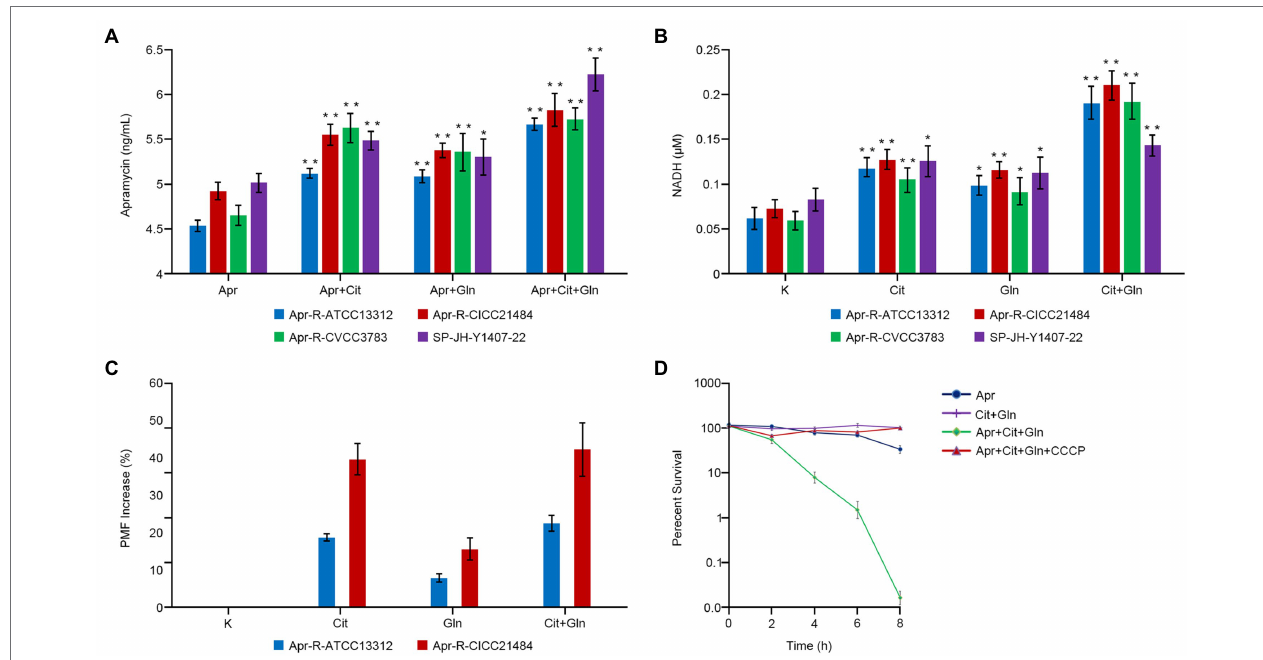
FIGURE 3 | Effect of exogenous citrulline and glutamine on intracellular drugs, NADH, and proton-motive force (PMF). (A) Concentration of Apramycin in bacteria cultured with different exogenous substances. (B) The NADH content of bacteria cultured with different exogenous substances. (C) The PMF of Apramycin-resistant Salmonella cultured with citrulline and (or) glutamine. (D) Survival curve of bacteria in different media with or without CCCP. “Apr” represents Apramycin alone, “Apr + Cit” represents the combination of Apramycin and citrulline; “Apr + Gln” represents the combination of Apramycin and glutamine; “Apr + Cit + Gln” represents the combination of Apramycin, citrulline, and glutamine; “K” represents the control group; “Cit” represents citrulline alone; “Gln” represents glutamine alone; and “Cit + Gln” represents citrulline plus glutamine. Results are displayed as the mean ± SEM, and significant differences are identified (* p < 0.05; ** p < 0.01, compared with the group without any exogenous substances) as determined using SPSS Statistics 26.0. Three biological repeats were carried out.